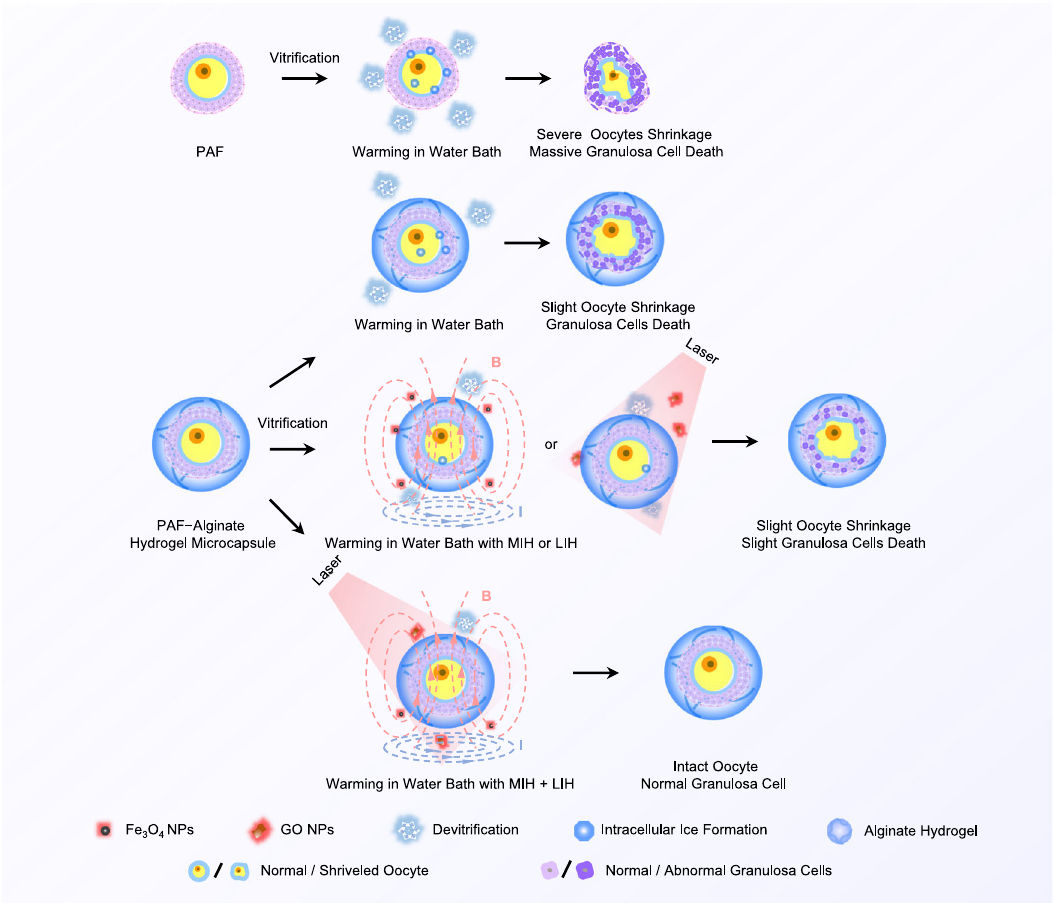
Fig.8|Possiblemechanismofmicroencapsulation,MIHandLIHtoimprovetheef fi ciencyoflow-pCPAPAFvitri fi cation. MIHmagneticinductionheating,LIHlaser- induced